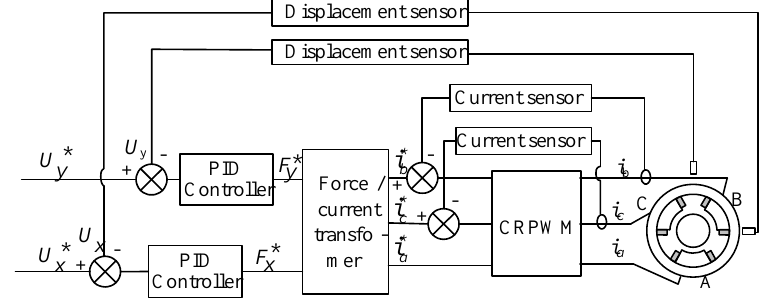
Figure 2. Control block diagram of three-pole radial HMB.